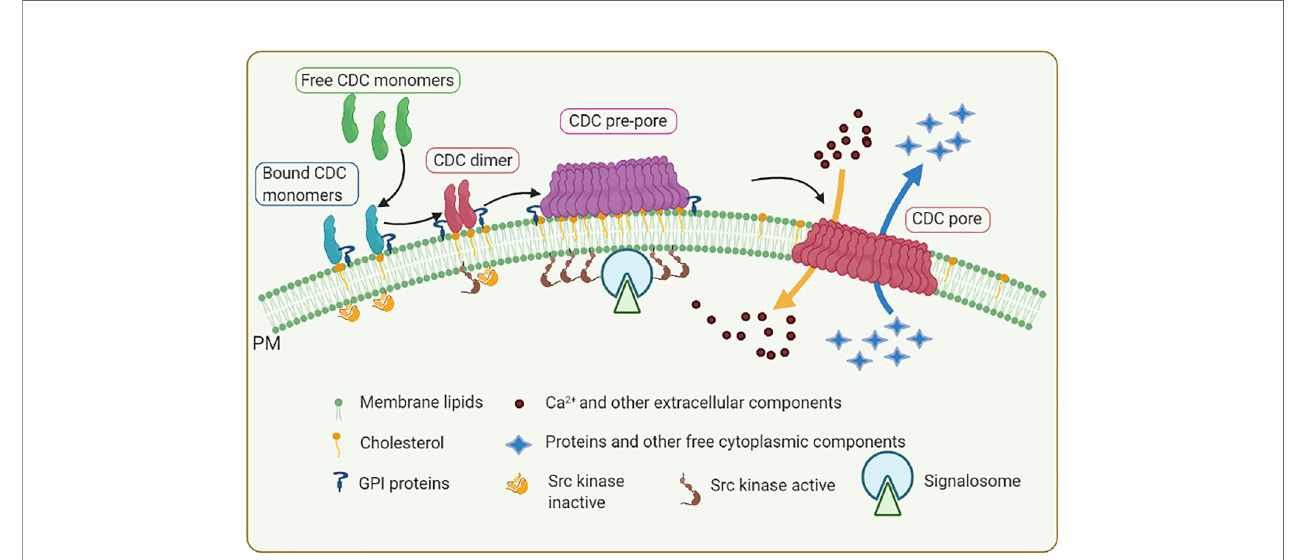
FIGURE 2 | Formation of membrane pores by CDCs. CDC monomers released from bacteria bind through their D4 domain to plasma membrane (PM) microdomains called lipid rafts enriched in cholesterol, GPI-anchored proteins, and Src family kinases. PM-bound monomers form dimers that polymerize into pre- pore structures containing 30 to 50 CDC monomers. In this process, CDCs induce aggregation of lipid raft components leading to formation of signaling assemblies called signalosome. The signalosomes are capable to initiate cell activation events. Individual CDCs in the pre-pore structure undergo conformational rearrangement and formation of membrane-spanning b -strands, leading to concerted membrane insertion and formation of the pore with approximately 25 nm in diameter. Formation of the transmembrane pore results in in fl ux of Ca 2+ into the cytoplasm and ef fl ux of K + , other small molecules (e.g., ATP), and proteins through the plasma membrane. These processes trigger various cell responses involved in repairing the plasma membrane and activating innate and acquired